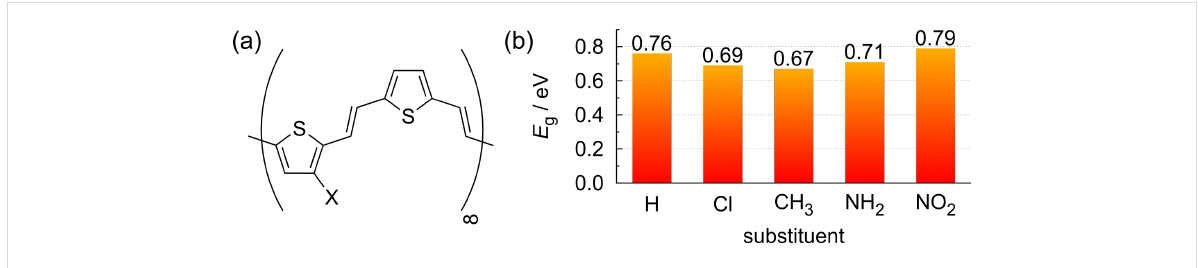
Figure 9: Considered vinyl-bridged polythiophene derivatives. (a) Structural formula, (b) band gaps E g of the corresponding polymers.